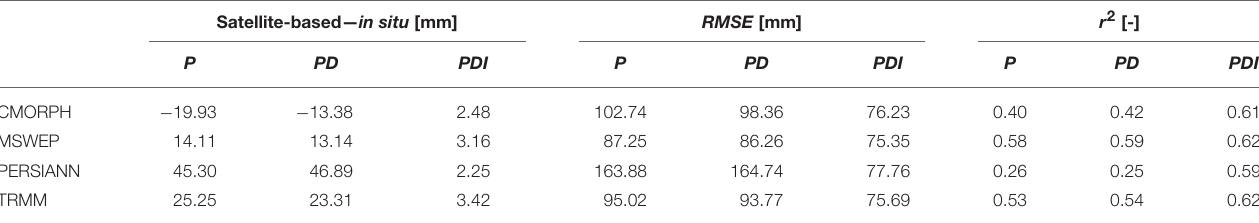
TABLE 5 | Statistical indicators of CMORPH, MSWEP, PERSIANN, and TRMM precipitation vs. in situ data (average of 502 validation weather stations). Satellite-based— in situ [mm] RMSE